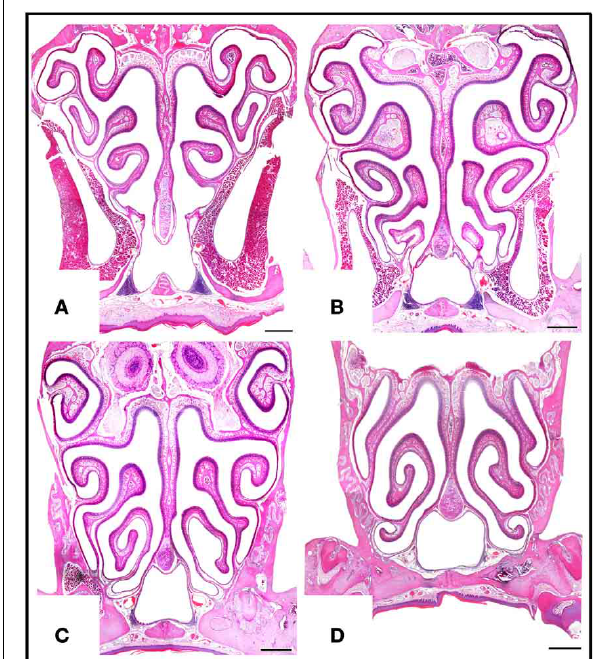
FIGURE 5 | Haematoxylin-eosin-stained transverse sections at four levels of the posterior nasal cavity, from anterior to posterior levels (A–D), where most of the MOE is located. Scale bars: 500 μ